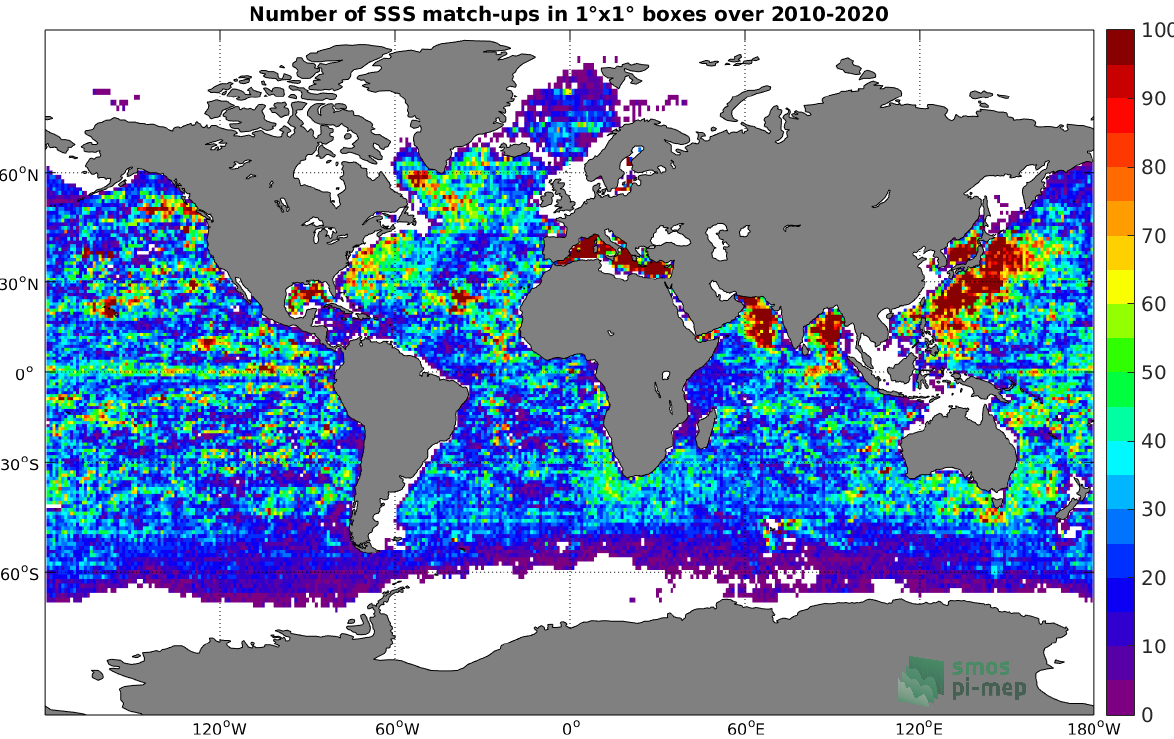
Figure 6. Number of SSS match-ups between Argo SSS and the CCI SSS L4 Merged-OI v3.2—30-day running (ESA) SSS product for the Global Pi-MEP region over 1 ◦ × 1 ◦ boxes and for the full satellite product